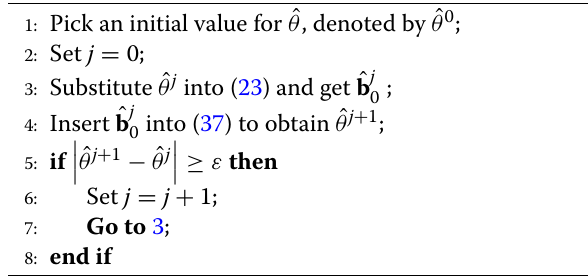
Algorithm 1 Iterative approach to minimization of